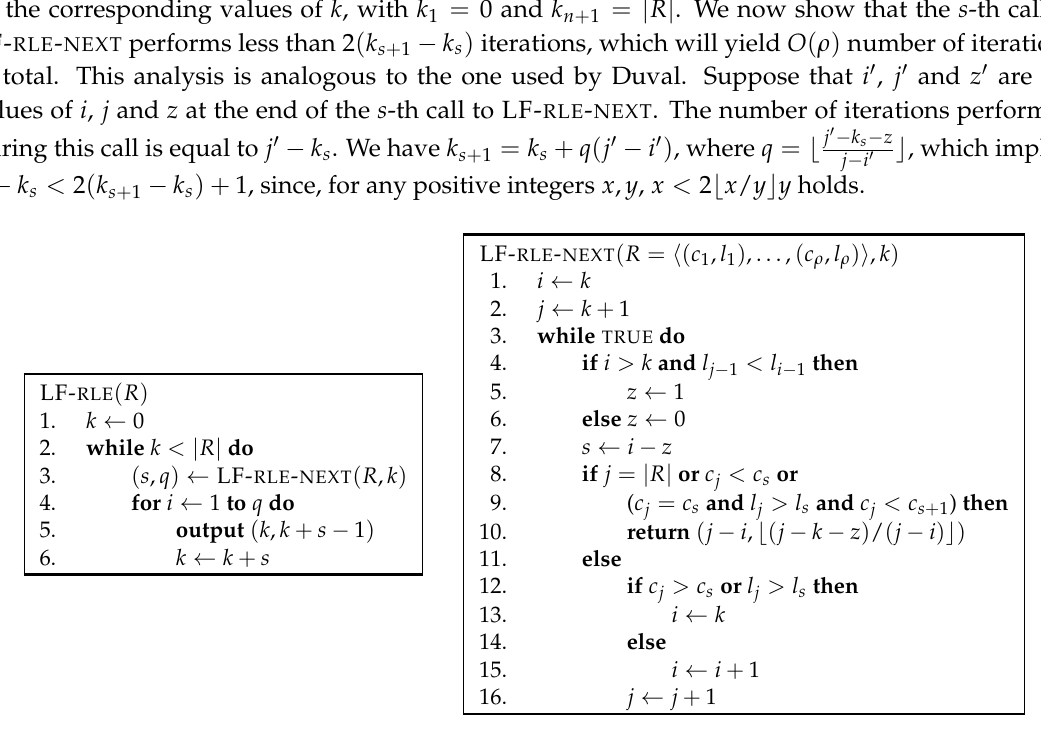
Figure 3. The algorithm to compute the Lyndon factorization of a run-length encoded